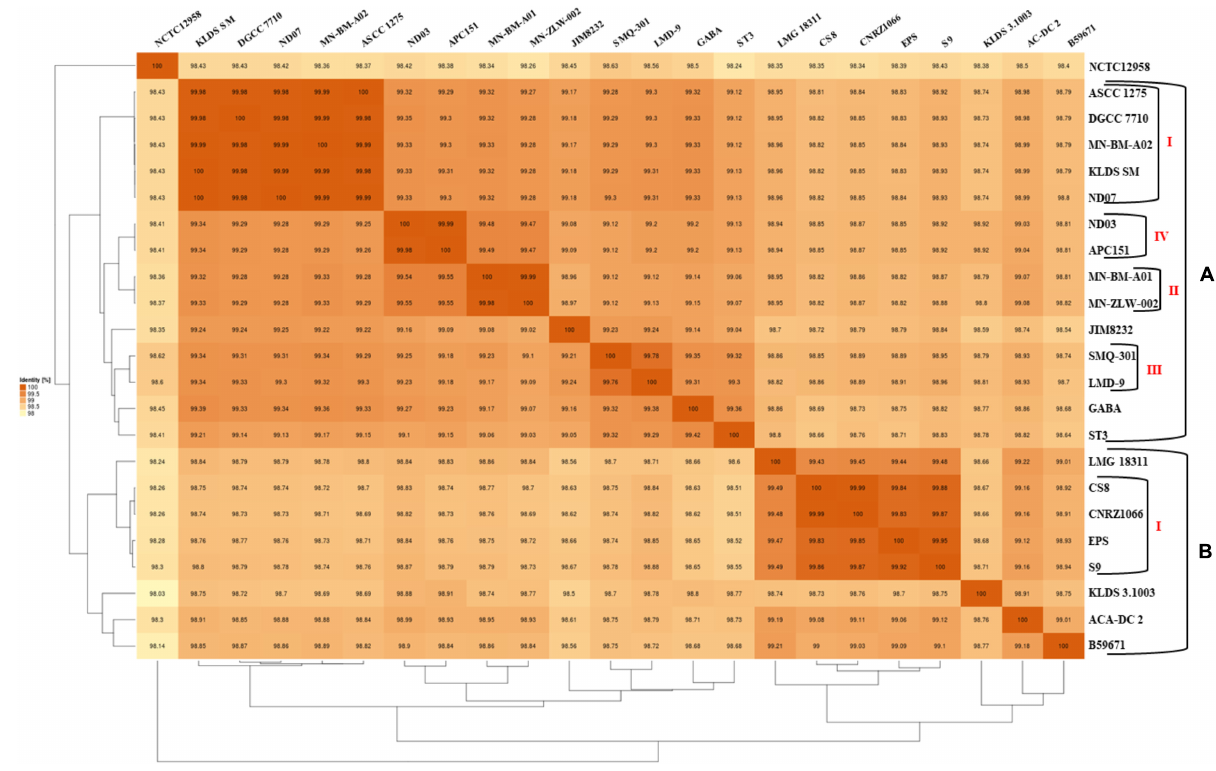
FIGURE 3 | Average nucleotide identity (ANI) phylogenetic tree and heat map visualization of the 23 S. thermophilus